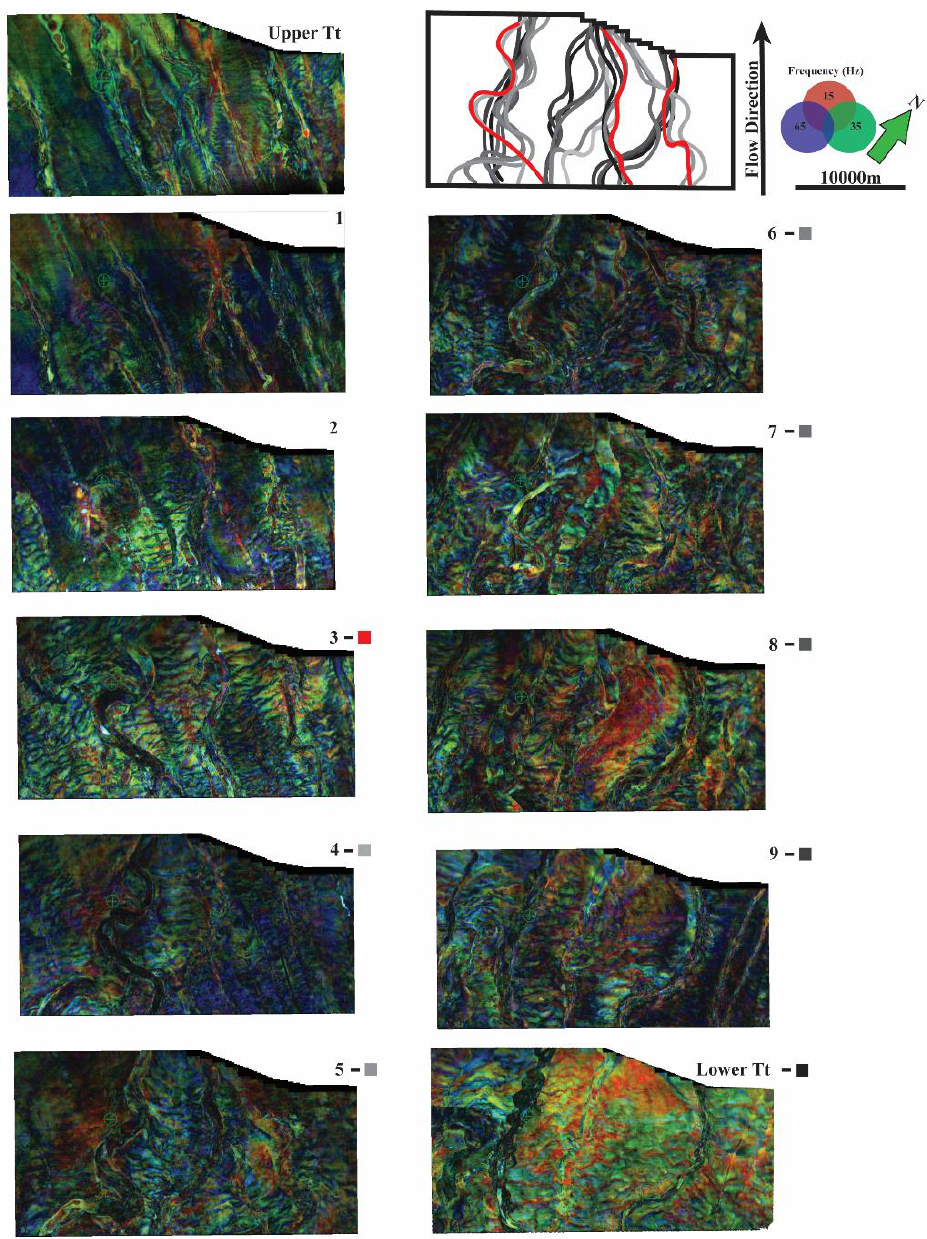
Figure 14. Stratal slices draped with RGB spectral-decomposition blends in the Hector-3D survey. The axes of the channel complexes in Lower Tt through SS 3 are traced and presented in the top-right to illustrate the migration of channel complexes through time.